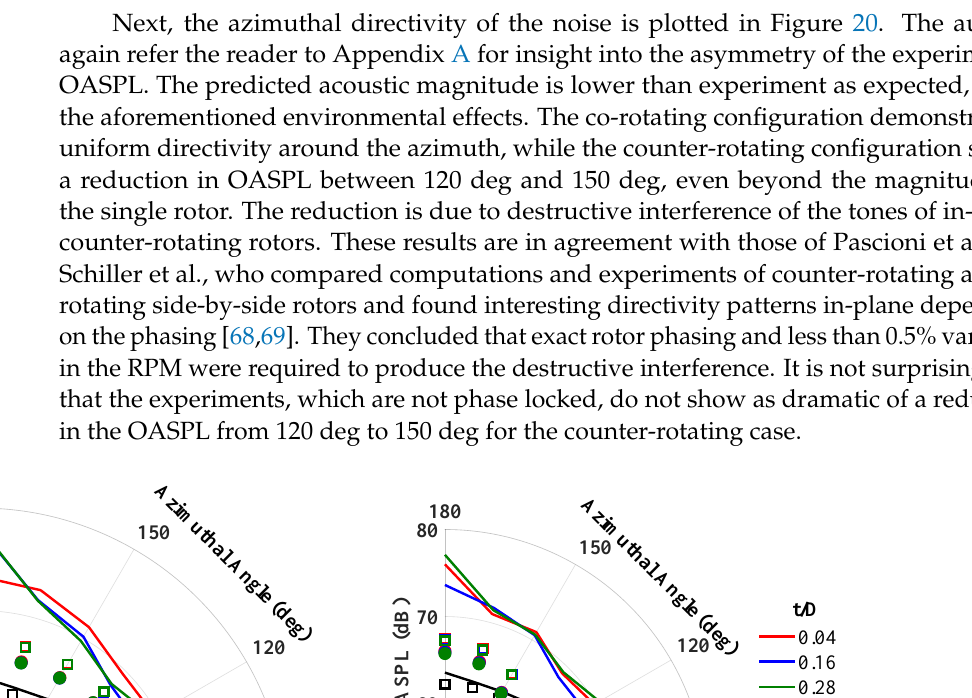
Figure 19. Overall sound pressure level of the dual rotors in hover at 6000 RPM versus elevation angle. Experimental results are shown as lines. Total noise from Helios/PSU-WOPWOP combined with UCD-Quietfly is shown as squares. Standalone Helios/PSU-WOPWOP predictions are shown as circles.